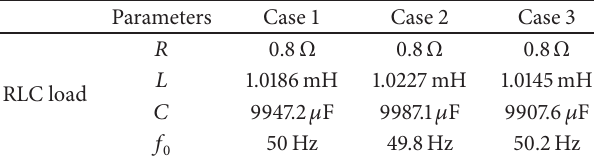
Table 2: Parameters of the RLC